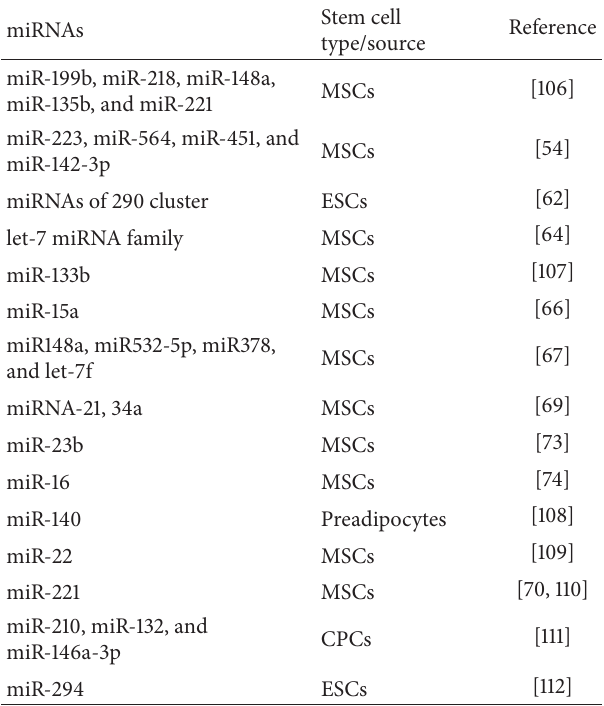
Table 2: Selectively enriched regulatory miRNAs from stem cell- derived